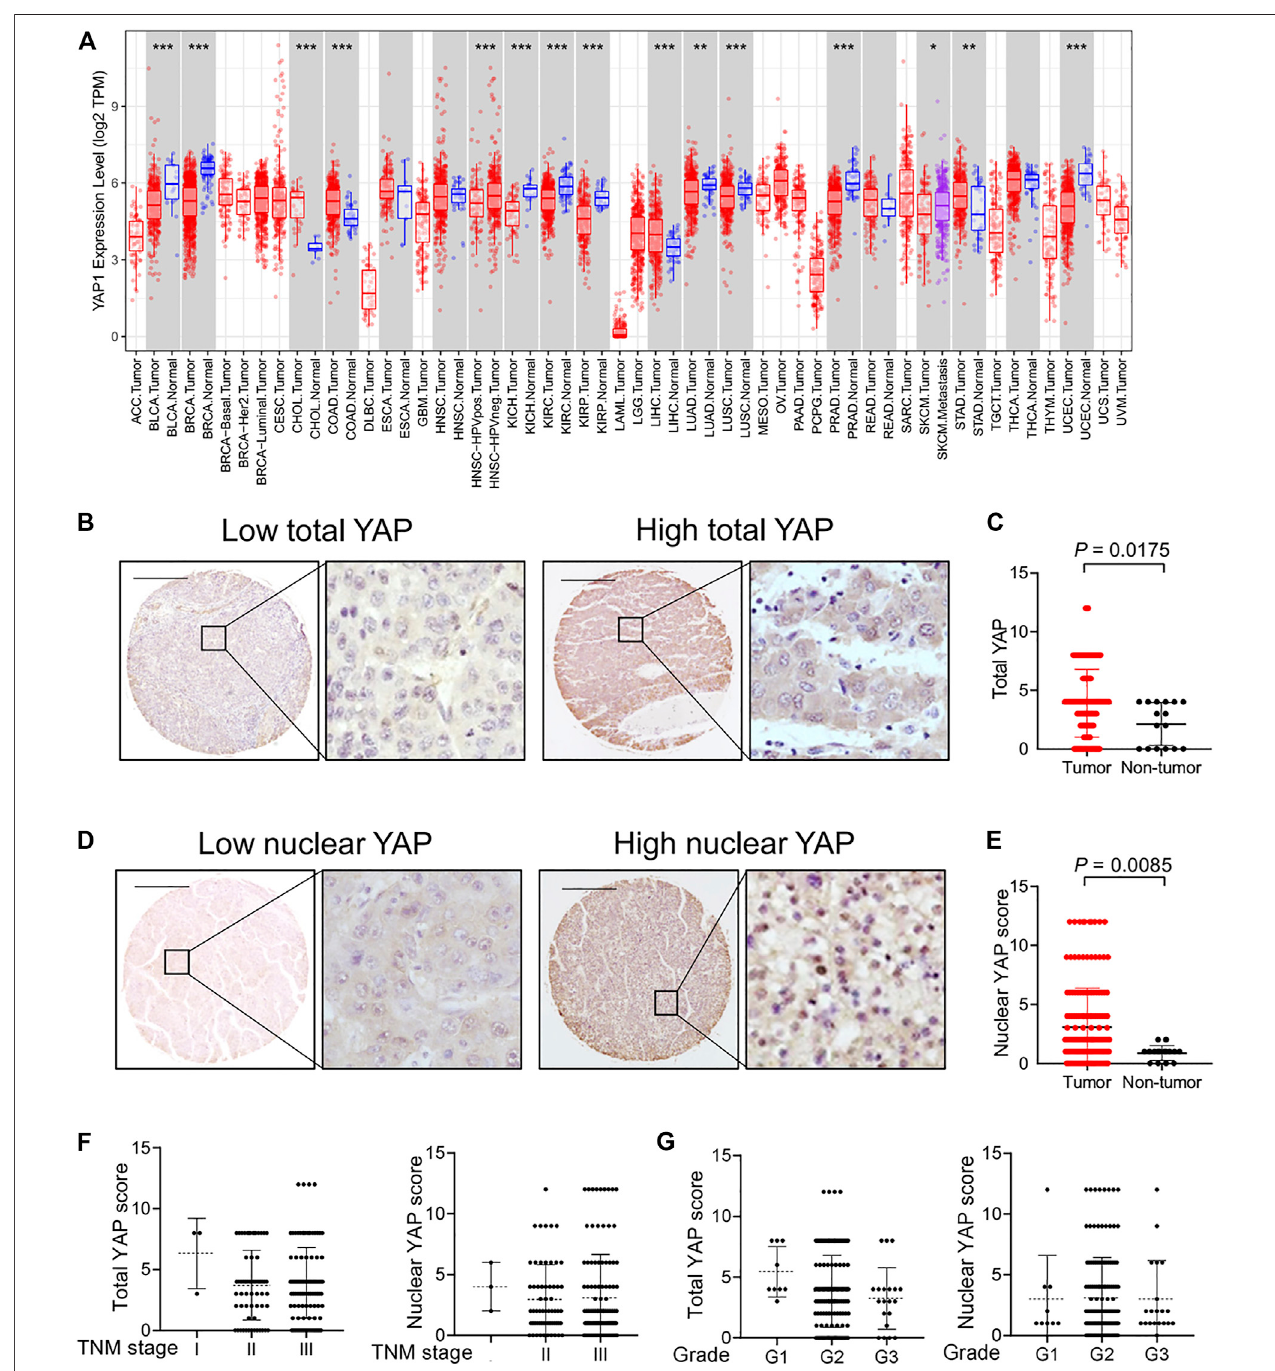
FIGURE1| Theexpressionand localizationofYAPinhumanhepatocellular carcinoma tissues. (A) YAPexpression indifferentcancertypesviatheTumorImmune Estimation Resource (TIMER) database. Adrenocortical carcinoma (ACC), bladder urothelial carcinoma (BLCA), breast invasive carcinoma (BRCA), cervical squamous cell carcinoma (CESC),cholangiocarcinoma (CHOL),colonadenocarcinoma (COAD),lymphoid neoplasmdiffuse large b-celllymphoma (DLBC),esophagealcarcinoma (ESCA), glioblastoma multiforme (GBM), head and neck squamous cell carcinoma (HNSC), kidney chromophobe (KICH), kidney renal clear cell carcinoma (KIRC), kidney renal papillary cell carcinoma (KIRP), acute myeloid leukemia (LAML), lower grade glioma (LGG), liver hepatocellular carcinoma (LIHC), lung adenocarcinoma (LUAD), lung squamous cell carcinoma (LUSC), mesothelioma (MESO), ovarian serous cystadenocarcinoma (OV), pancreatic adenocarcinoma (PAAD), pheochromocytoma and paraganglioma (PCPG), prostate adenocarcinoma (PRAD), rectum adenocarcinoma (READ), sarcoma (SARC), skin cutaneous melanoma (SKCM), stomach adenocarcinoma (STAD), testicular germ cell tumors (TGCT), thyroid carcinoma (THCA), thymoma (THYM), uterine corpus endometrial carcinoma (UCEC), uterine carcinosarcoma (UCS), uveal melanoma (UVM). (B) Expression of YAP protein in hepatocellular carcinoma tissues. Scale bars, 200 μ m. (C) Expression